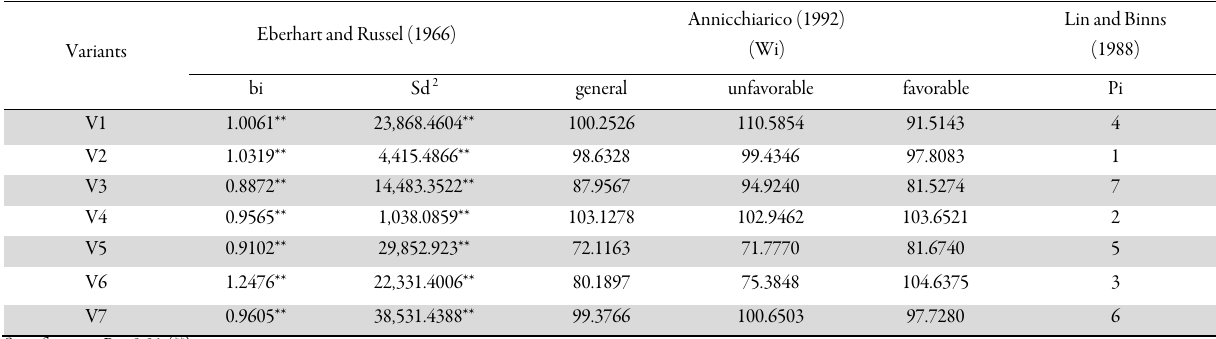
Table 2. Stability parameters of dry mass yield Variants